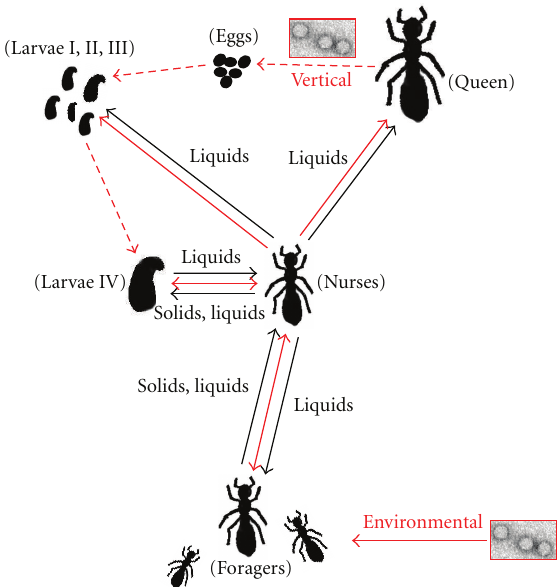
Figure 5: Routes proposed for SINV-1 (and possibly SINV-2 and SINV-3) colony acquisition and dissemination [81]. SINV-1 exhibits a tissue tropism toward the midgut, and large quantities of virus are detected in the midgut contents of adults and larvae of infected colonies. Thus, colony dissemination of SINV-1 appears to coincide with the food distribution route for the colony. Black arrows illustrate the flow of food throughout the colony and red arrows the corresponding movement of SINV-1. Two modes of virus acquisition are likely environmental (from outside sources entering the colony by way of foragers) and vertical (from infected queens). The vertical route of distribution is illustrated by broken red lines. The food flow diagram was adapted from Vinson and Sorensen